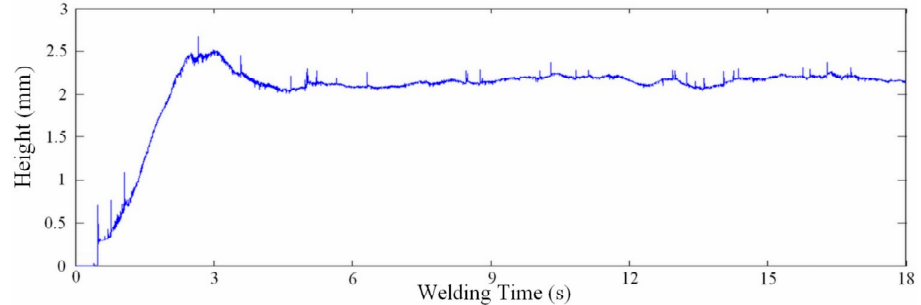
Figure 13. Real-time height measurement for a work point of 21 V and 6 m/min, using a welding speed of 10 mm/s and 100 fps as sampling rate [22].